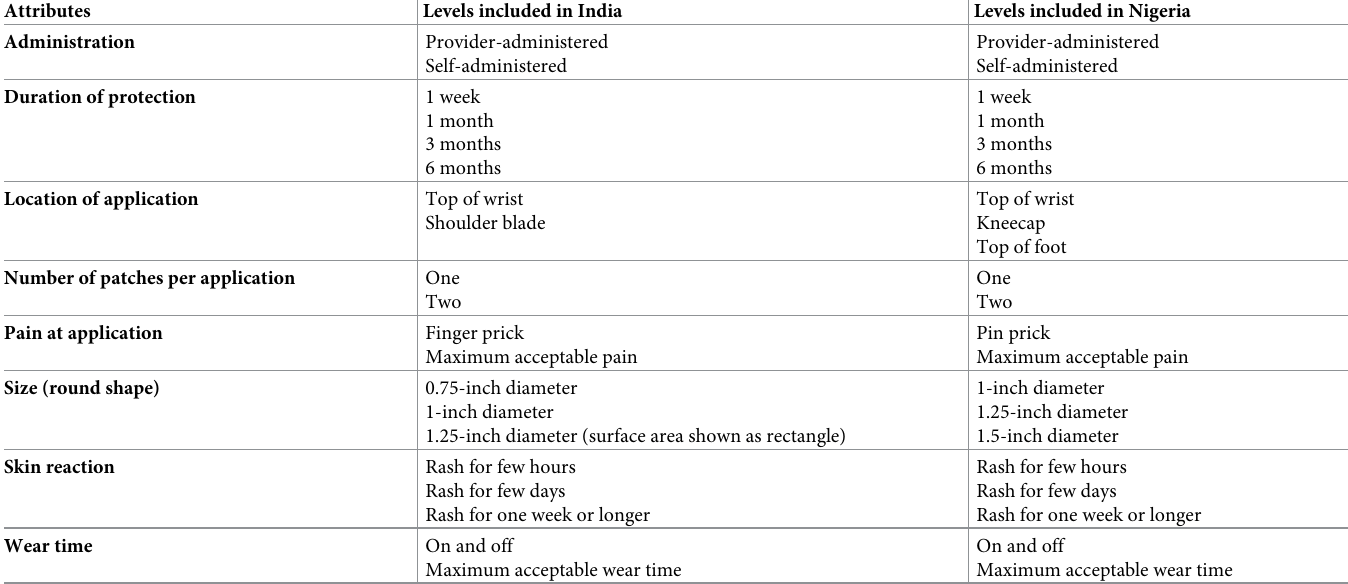
Table 1. Attributes and levels included in topic